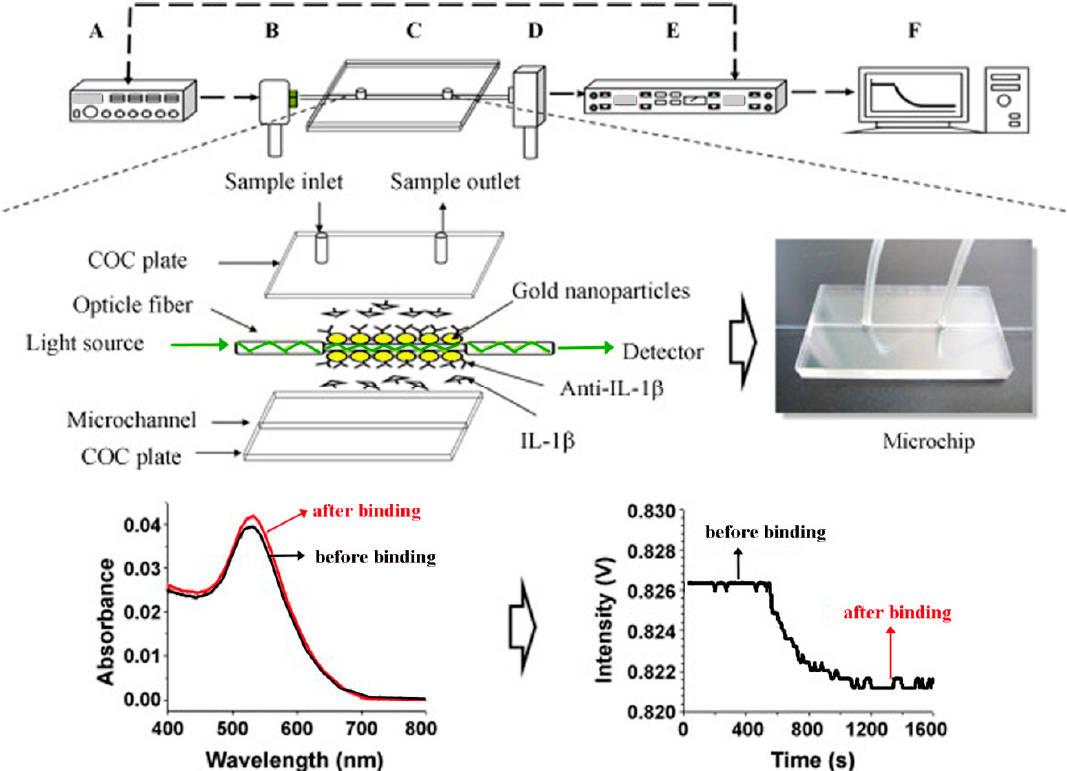
Figure 16. The schematics represent a FOPPR sensor setup and its working principle. The setup consists of a function generator, a light-emitting diode, a FOPPR sensing chip, a photodiode, a lock-in amplifier, and a computer, as indicated in A through F, respectively. Biomolecular binding at the surface of the functionalized AuNP layer (indicated in yellow) results in increased absorbance and decreased light intensity exiting the optical fiber (shown in green). Reproduced with permission from Ref. [122] Copyright (2010) Elsevier.